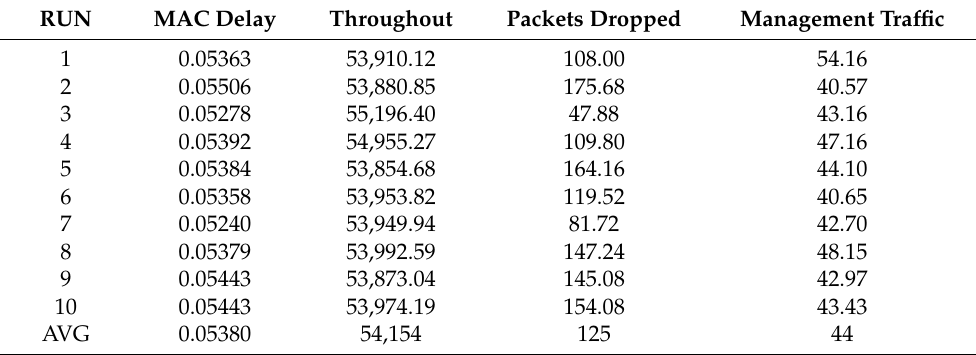
Table 18. Fire Station Scenario Counting